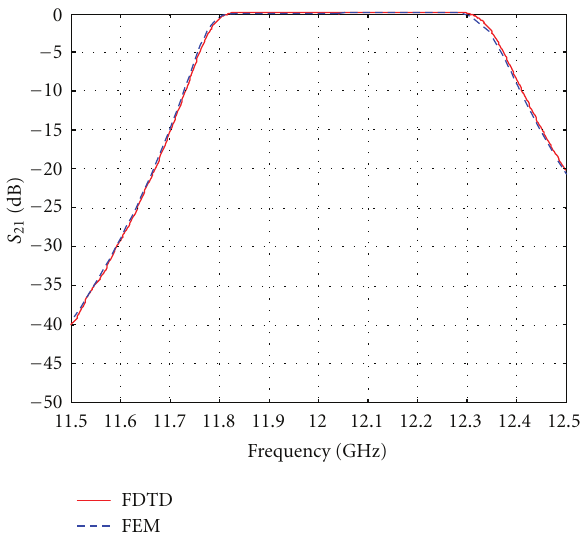
Figure 12: Transmission coe ffi cient of waveguide filter generated by using enhanced FDTD method and